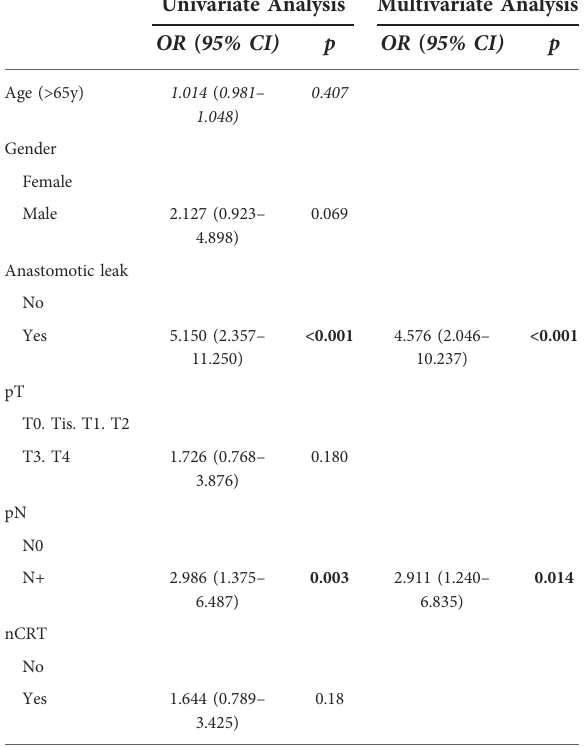
TABLE 4 Univariate and Multivariate analysis of Local Recurrence.